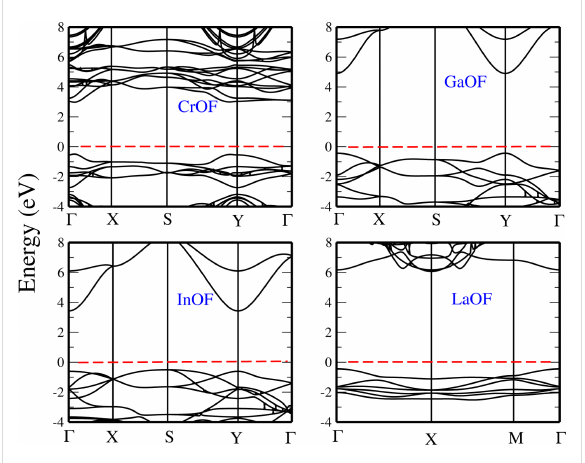
Figure 8: Band structures of the monolayers CrOF, GaOF, InOF, and LaOF, using the HSE functional. The Fermi level is set to 0 eV.